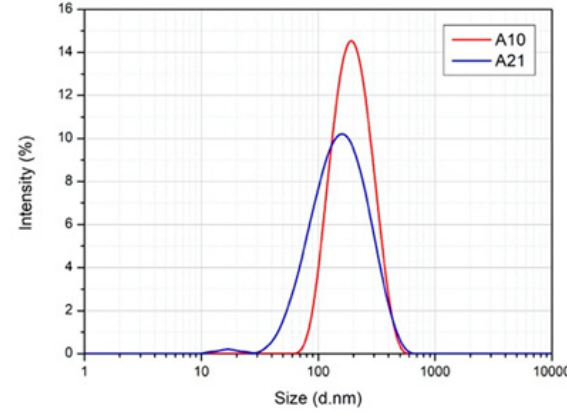
Figure 8. DLS traces of A10 and A21 after a storage period of six months.